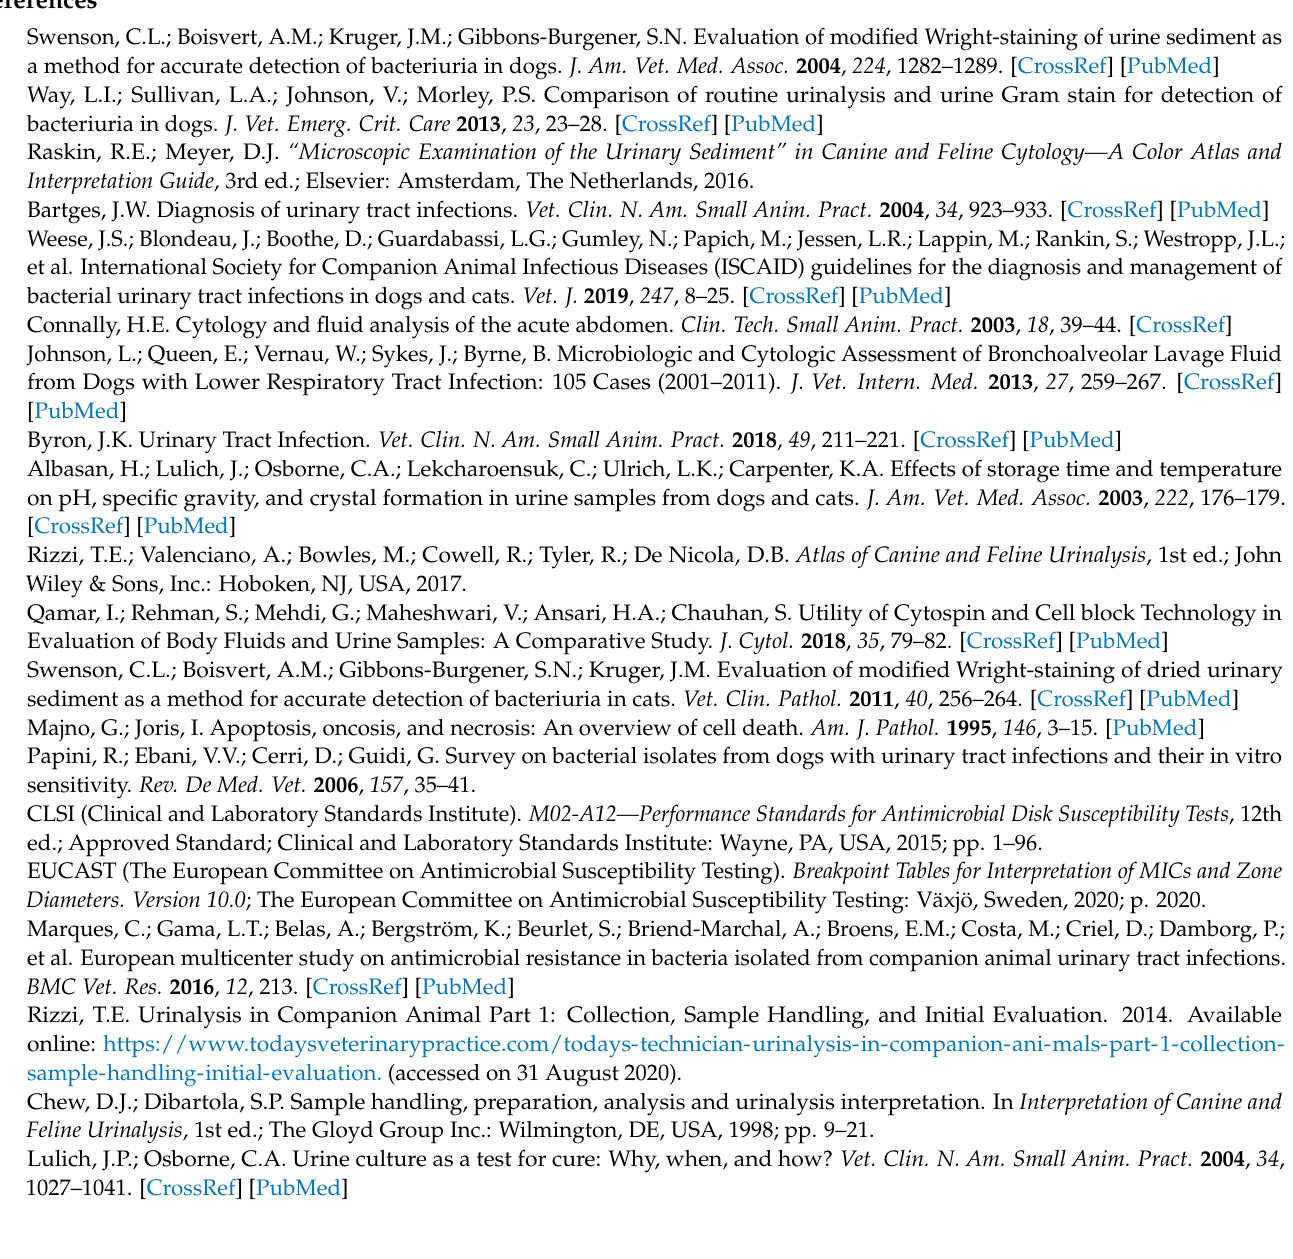
Streptococcus spp. AP, ampicillin; AC, amoxicillin clavulanate; CV, cefovecin; CZ cefazolin; CX, ceftriaxone; EF, enrofloxacin; MF, marbofloxacin; AZ, azithromycin; AK, amikacin; CL, clindamycin; DX, doxycycline. S, Sensitive; I: intermediate; R, Resistant; NT,